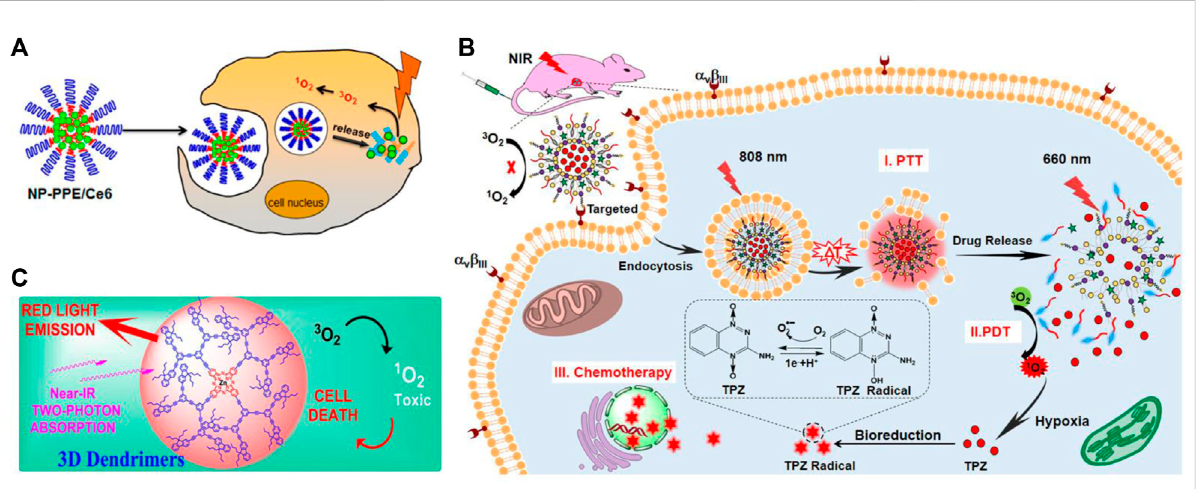
FIGURE 3 Schematicillustrationsofbiocompatiblenanocarriersincancerphotodynamictherapy: (A) Polymericnanoparticles — reprintedwithpermission from reference (Ding et al., 2015), Copyright 2015, American Chemical Society; (B) Liposomes — reprinted with permission from reference (Dai et al., 2019), Copyright 2019, American Chemical Society; and (C) Dendrimers — reprinted with permission from reference (Abid et al., 2021), Copyright 2021, American Chemical